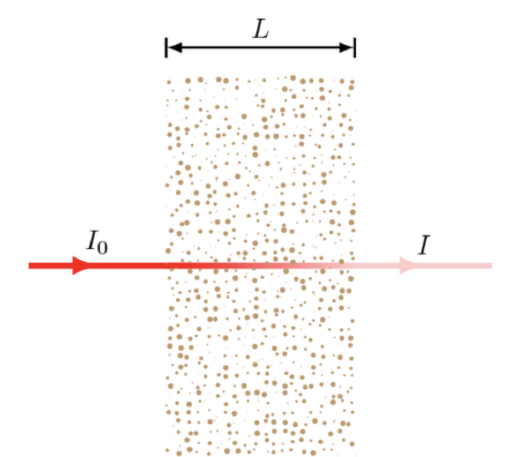
Figure 16. Representation of absorbance detection, where I 0 represents the initial light input, I represents the resulting transmitted signal and L being the optical path